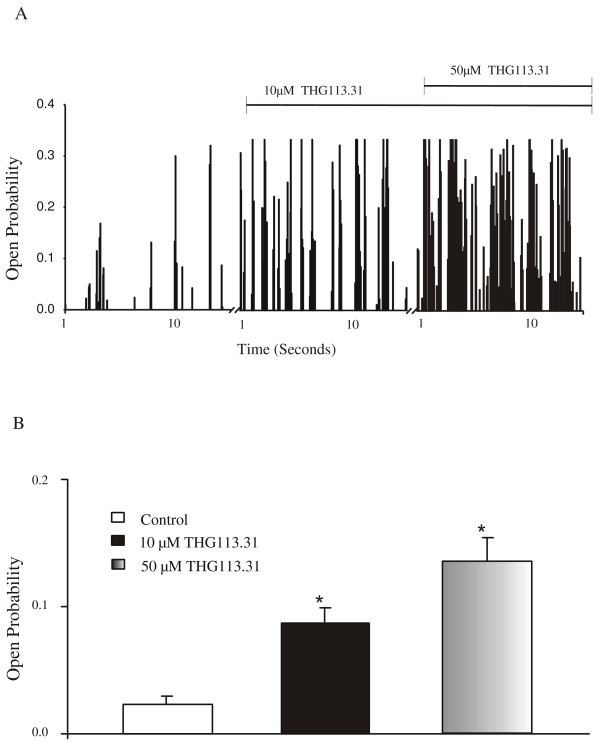
THG113.31 opens BKCa channel activity in human myometrial smooth muscle cells in a concentration-dependent manner. A Activity plot of BKCa channel open probability in a single cell-attached patch before and 15 min after exposure to cumulative doses of 10 and 50 μM THG113.31. Vertical bars are channel activity during a 100-ms test pulse to +40 mV. Recording time under each condition was 10 s, as indicated on the time axis. Breaks in the time axis represent drug incubation periods when channel activity was not recorded. Period of drug exposure is indicated by horizontal lines above the histogram. B Each bar represents the average channel open probability obtained from cell attached patches (+40 mV) before and 15 min after additions of 10 and 50 μM THG113.31, respectively. *Significant increase in channel activity compared to control (n = 6; P < 0.005)